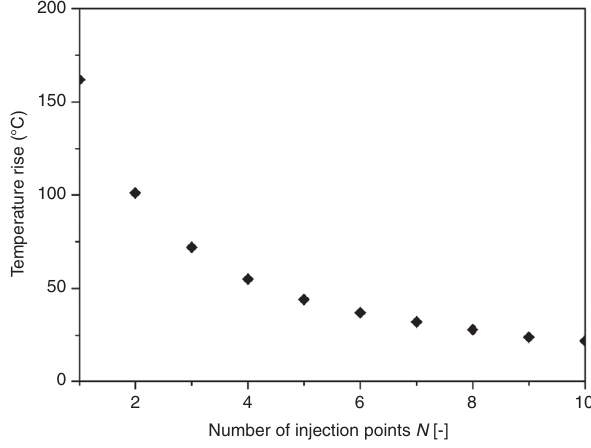
Figure 4 Maximal temperature at the first injection point of a multi- injection reactor with equal flow distribution as function of the total amount of injection